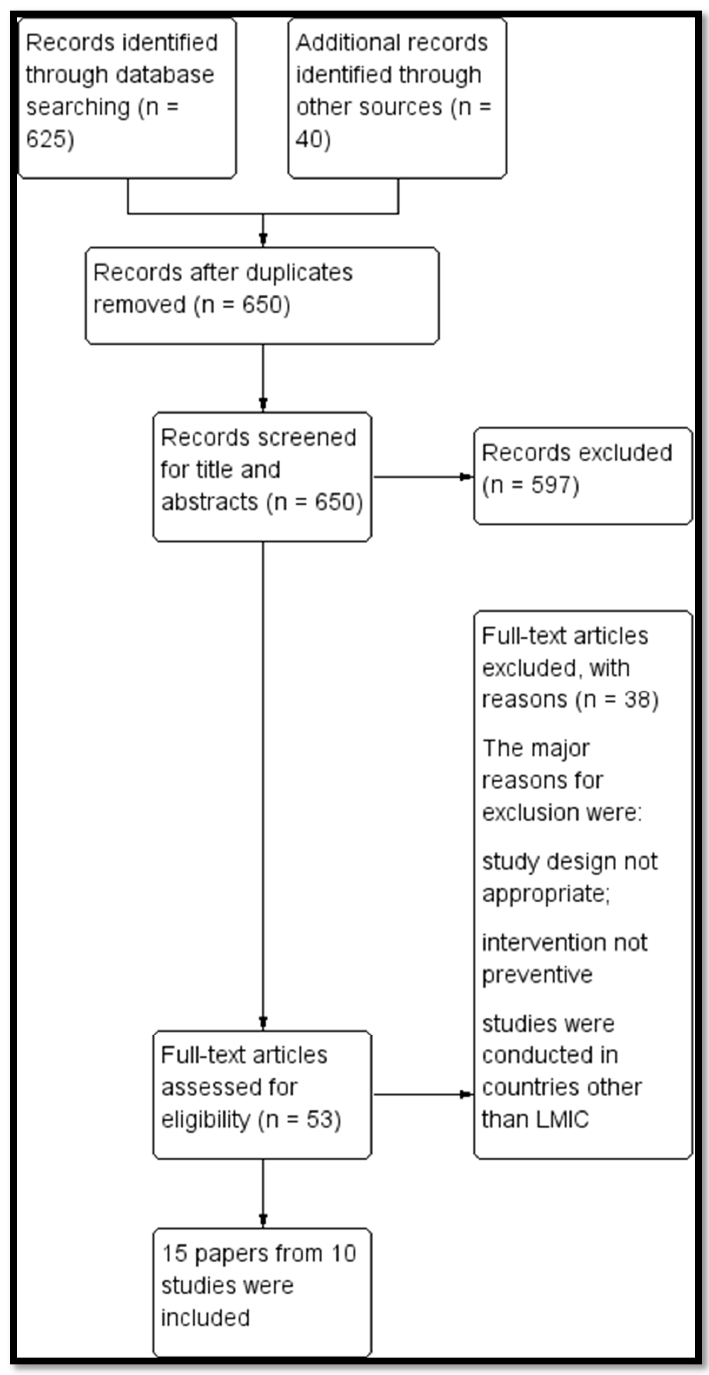
Figure 1. Search flow diagram.